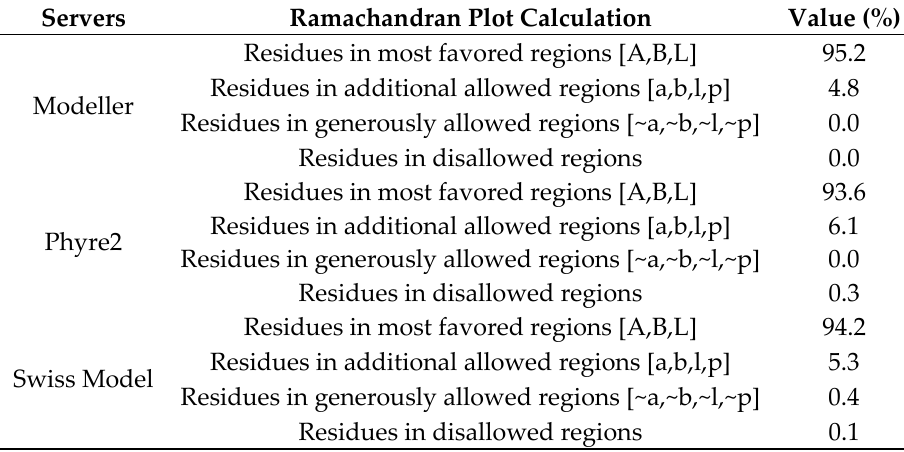
Figure 3. Structure of NCGM946K2_146 predicted by Modeller. Table 5. Ramachandran plot